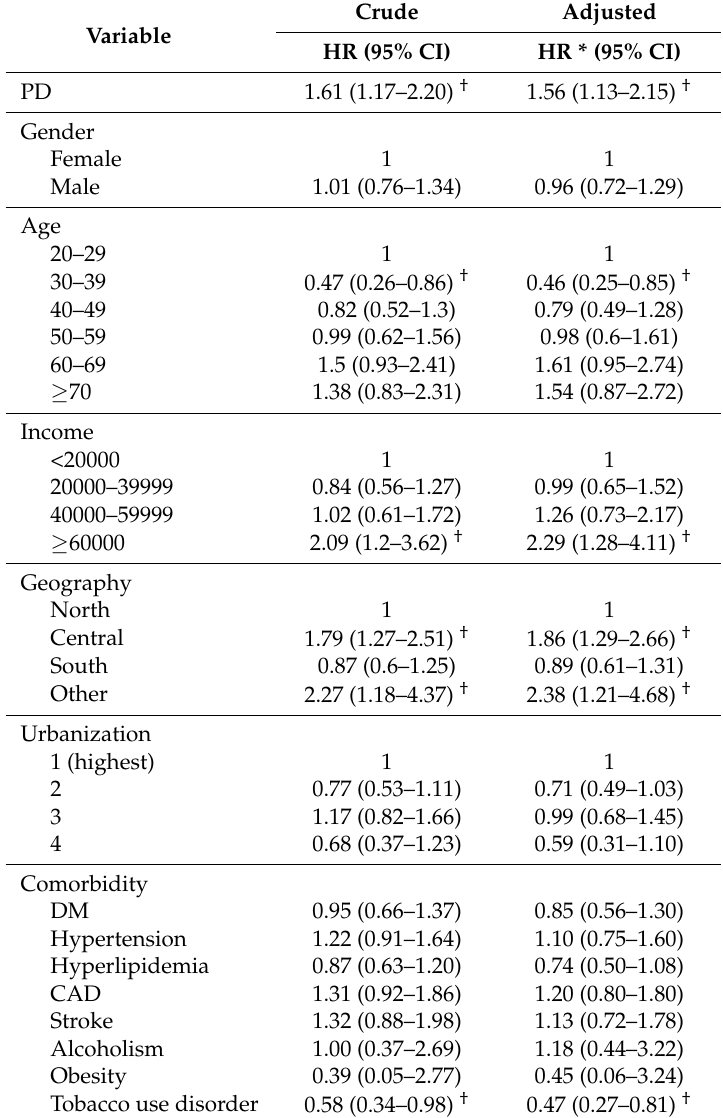
Table 3. Independent predictors of Ulcerative colitis identified by Cox regression